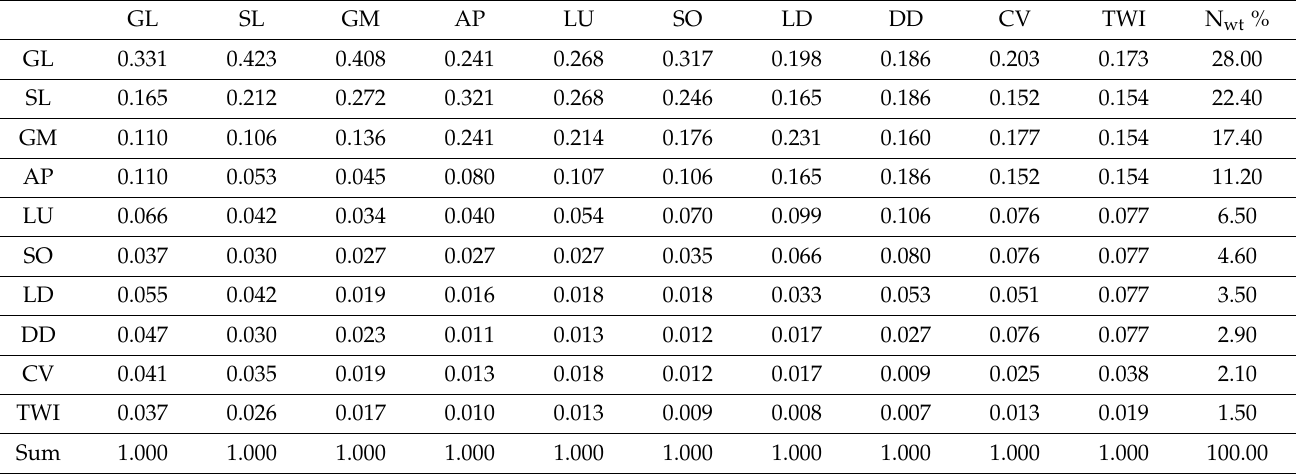
Table 4. Normalized weight of the